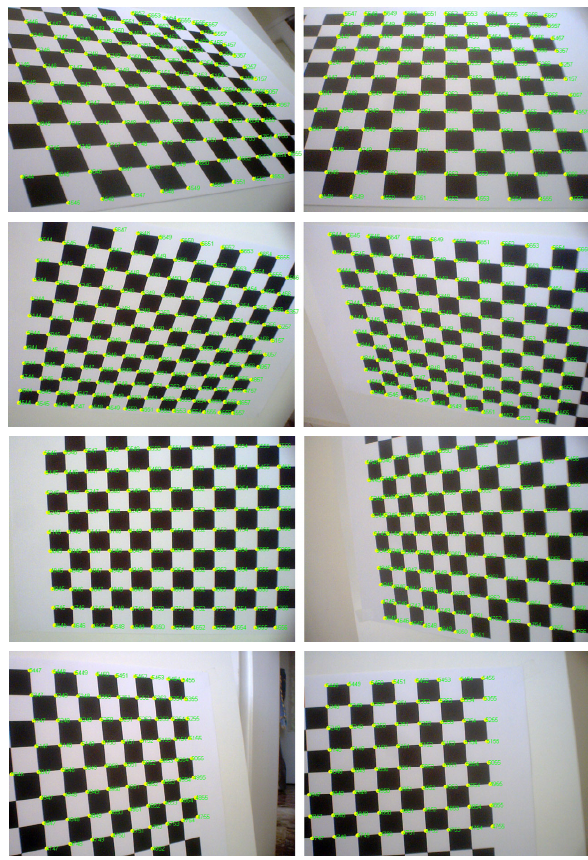
Figure 4. Stereo-pair used in the reconstruction of the